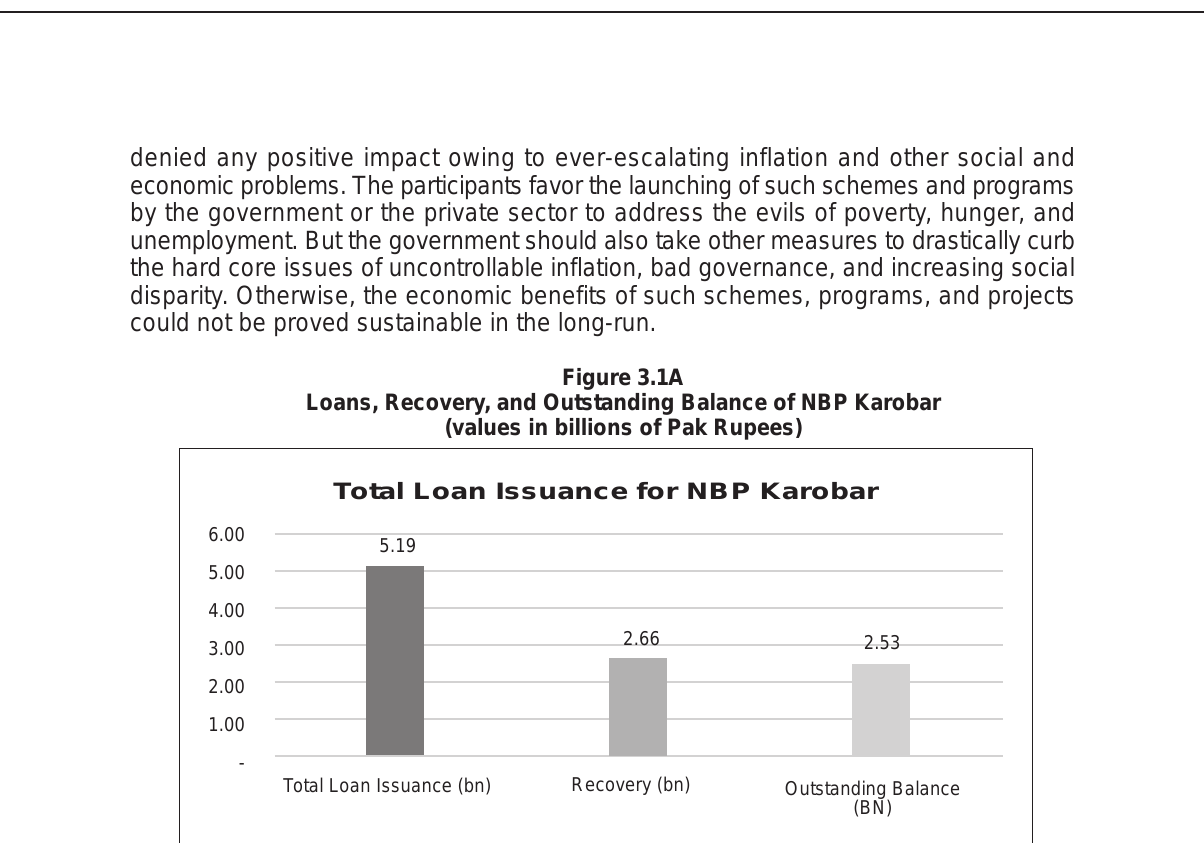
Figure 3.1B % of Recovery and